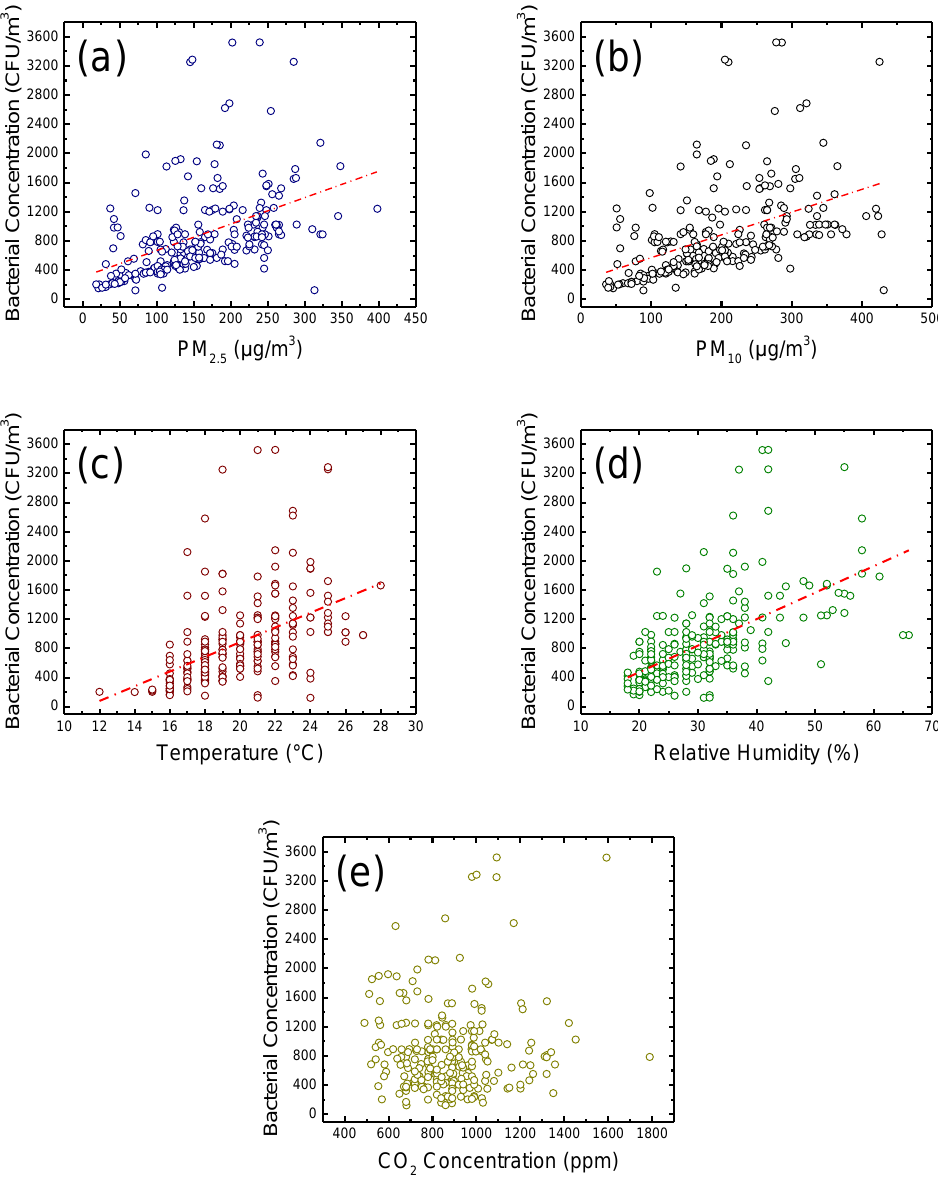
Figure 1. Relationships between the concentration of indoor airborne culturable bacteria vs. ( a ) indoor PM 2.5 , ( b ) indoor PM 10 , ( c ) temperature, ( d ) relative humidity, and ( e ) CO 2 concentration.